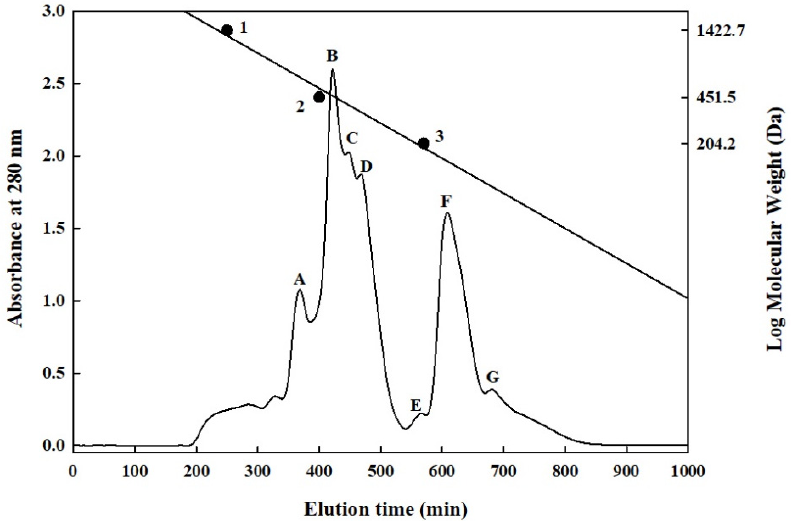
Figure 1. Sephadex G-25 column chromatography of peptides separated from HPP-FH-PR6G. ● —